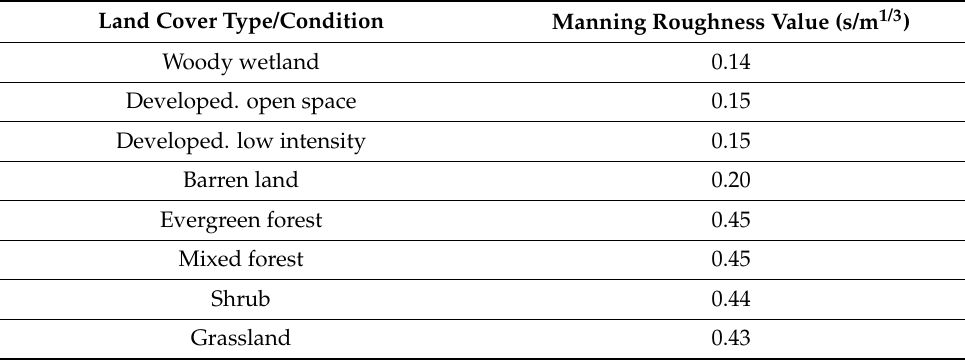
Table 2. The Manning roughness parameter values for the routing